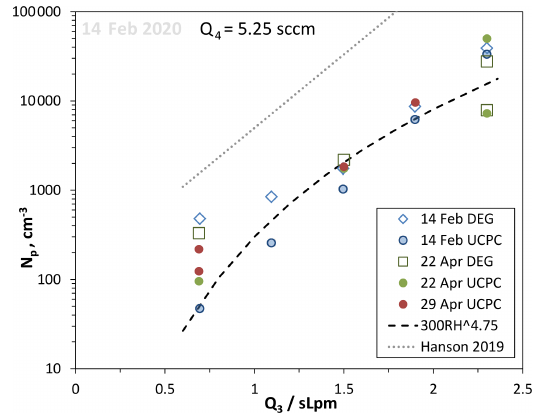
Figure 8. Variation in N p with relative humidity, set by the flow through the humidifier, Q 3 (dates in 2020). RH ranges from 24% to 81% for the range of Q 3 in the figure. HONO level was kept constant, Q 4 = 5 . 25sccm. A power dependency on RH of 4.75 is shown as the dashed line. The thin dotted line is the exponential fit to the RH dependency found in Hanson et al. (2019) at Q 4 = 4 .